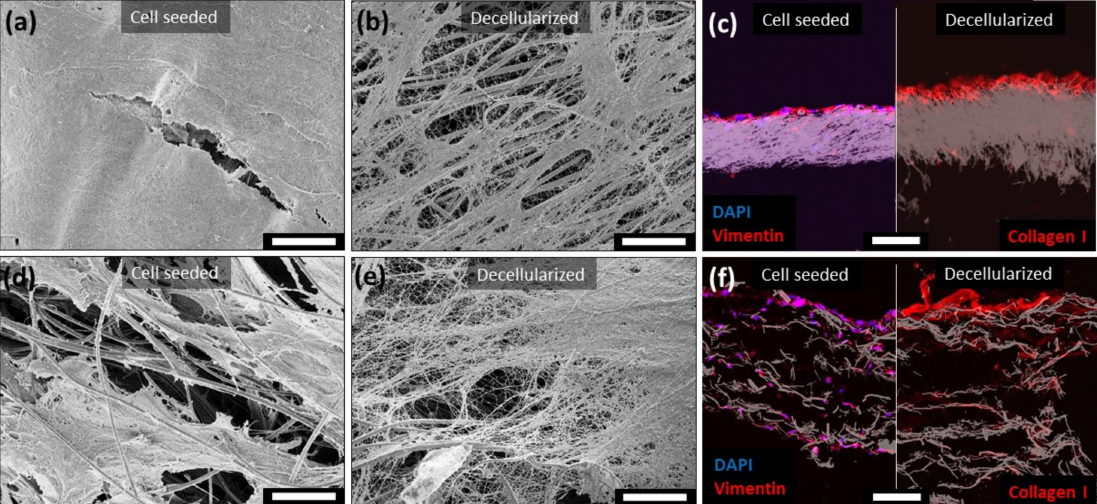
Figure 2. Electrodes in extracellular matrix (ECM) modification by human dermal fibroblasts (hdf). ( a ) SEM image of the sell-seeded surface demonstrates a closed cellular surface after four weeks of culture on the dense meshes. ( b ) After decellularization, a nano scaled protein network remained on top of the carbon fibers. ( c ) Immunofluorescence staining of the cross section affirmed the location of hdf (vimentin, left) and the ECM (Collagen I, right) just on top of the dense electrode. ( d ) Enhanced mesh openings and porosity improved the cell migration into the nanofiber electrode and reduced the thickness of the cellular layer on top of the scaffold. ( e ) Synthesized ECM on top of and in the porous electrode. ( f ) The porosity led to the colonization inside the electrode by hdf (vimentin, left) as well as the ECM synthesis (Collagen I, right). Scale bars correlate to 10 µ